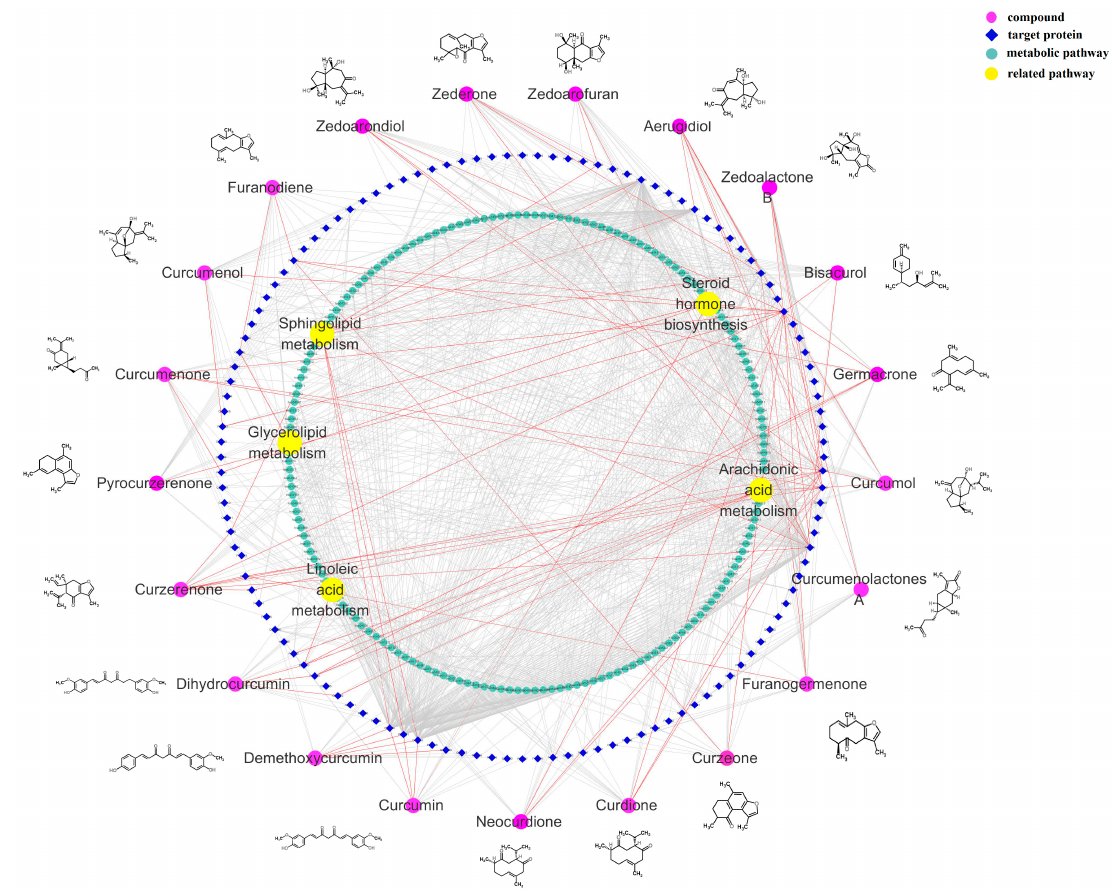
Figure 7. Compound-target-metabolic pathway network.